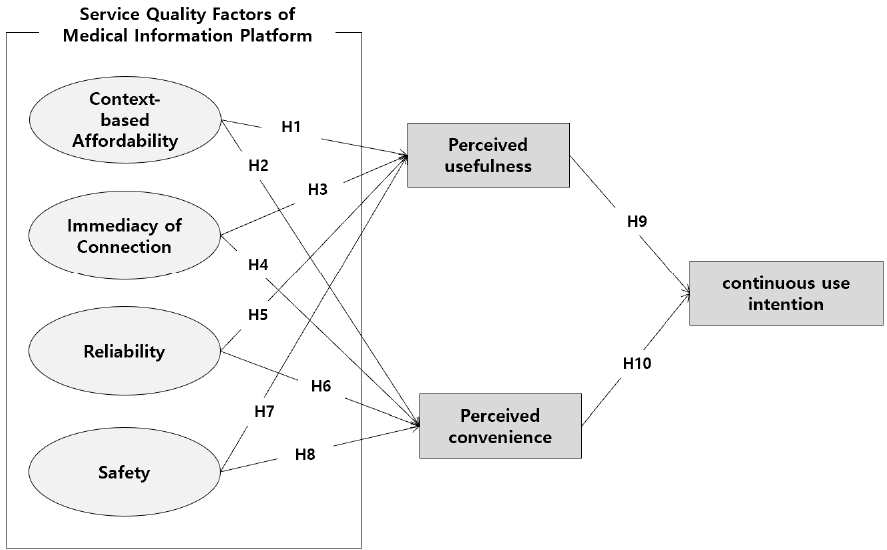
Figure 1. Research